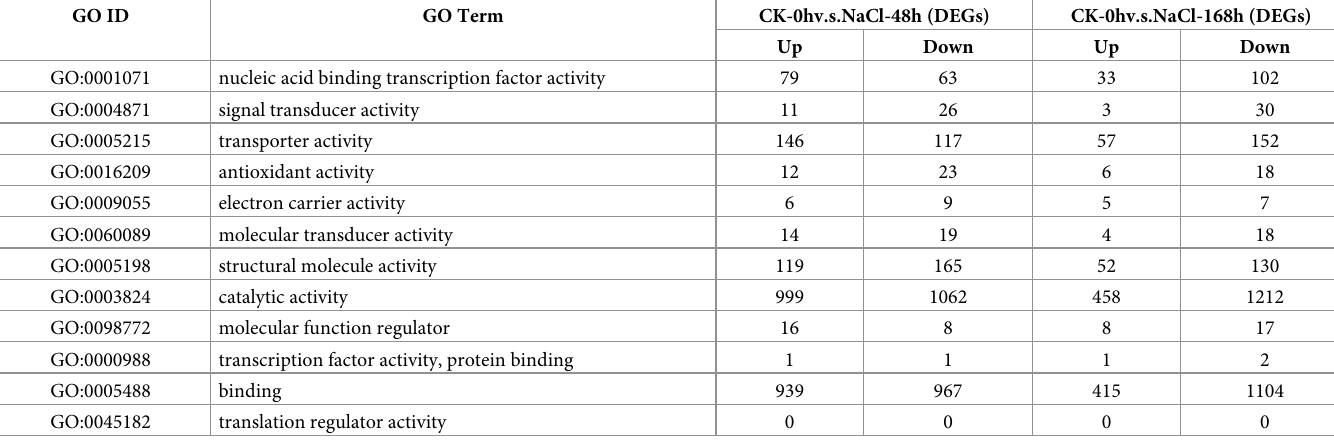
Table 3. GO enrichment analysis of molecular function of